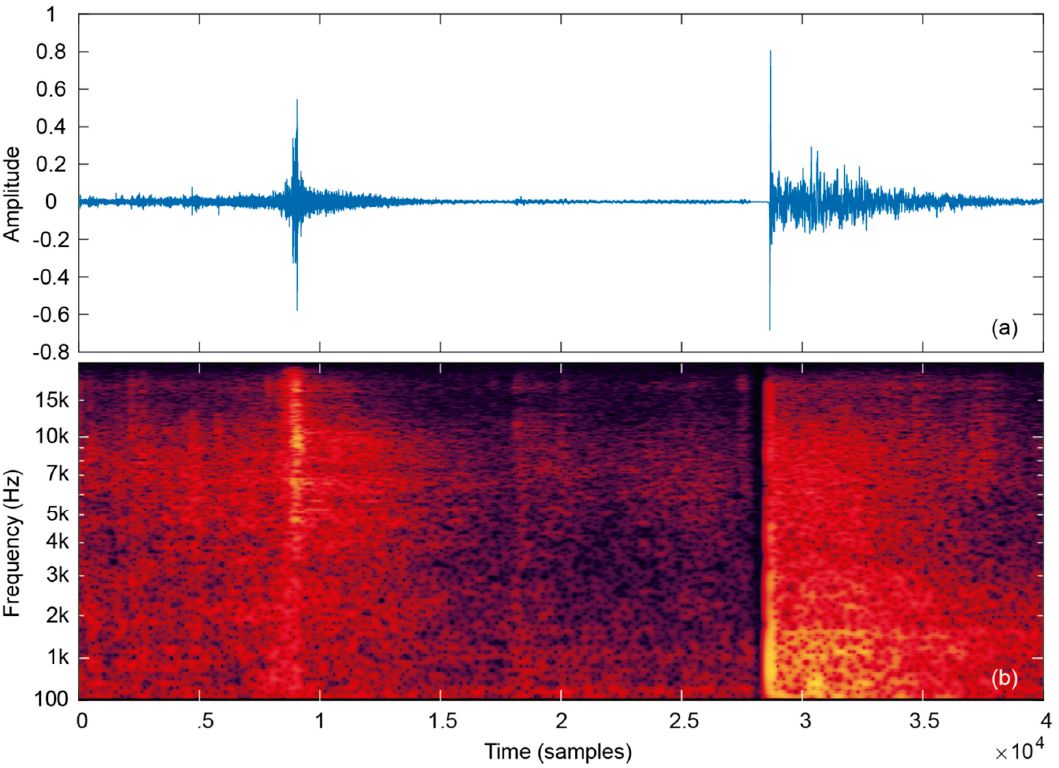
Figure 2. Typical jump audio signal showing take-off and landing events. ( a ) Waveform; ( b ) spectrogram.